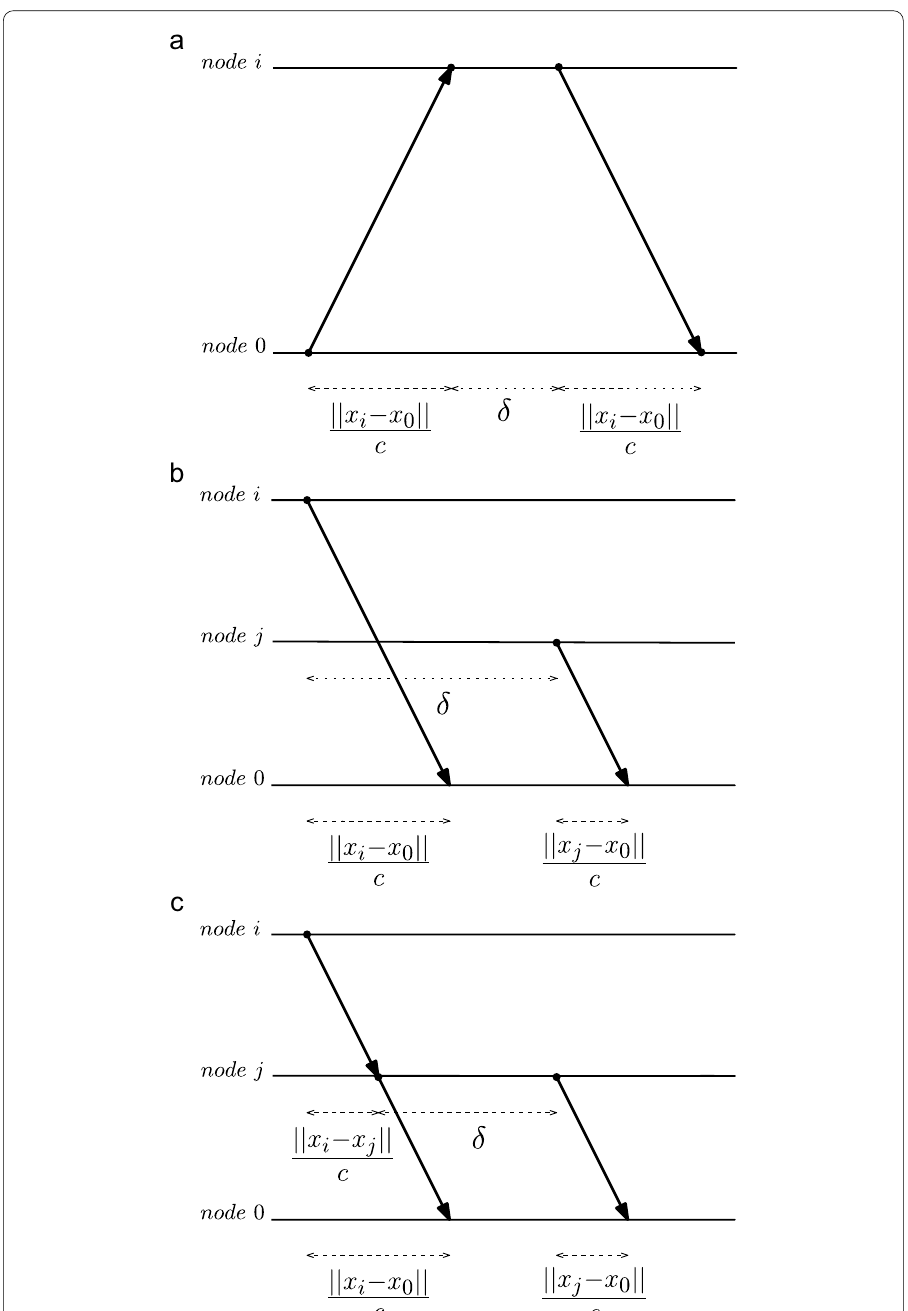
Fig. 2 Timing diagrams illustrating node transmitting signals in three different localization